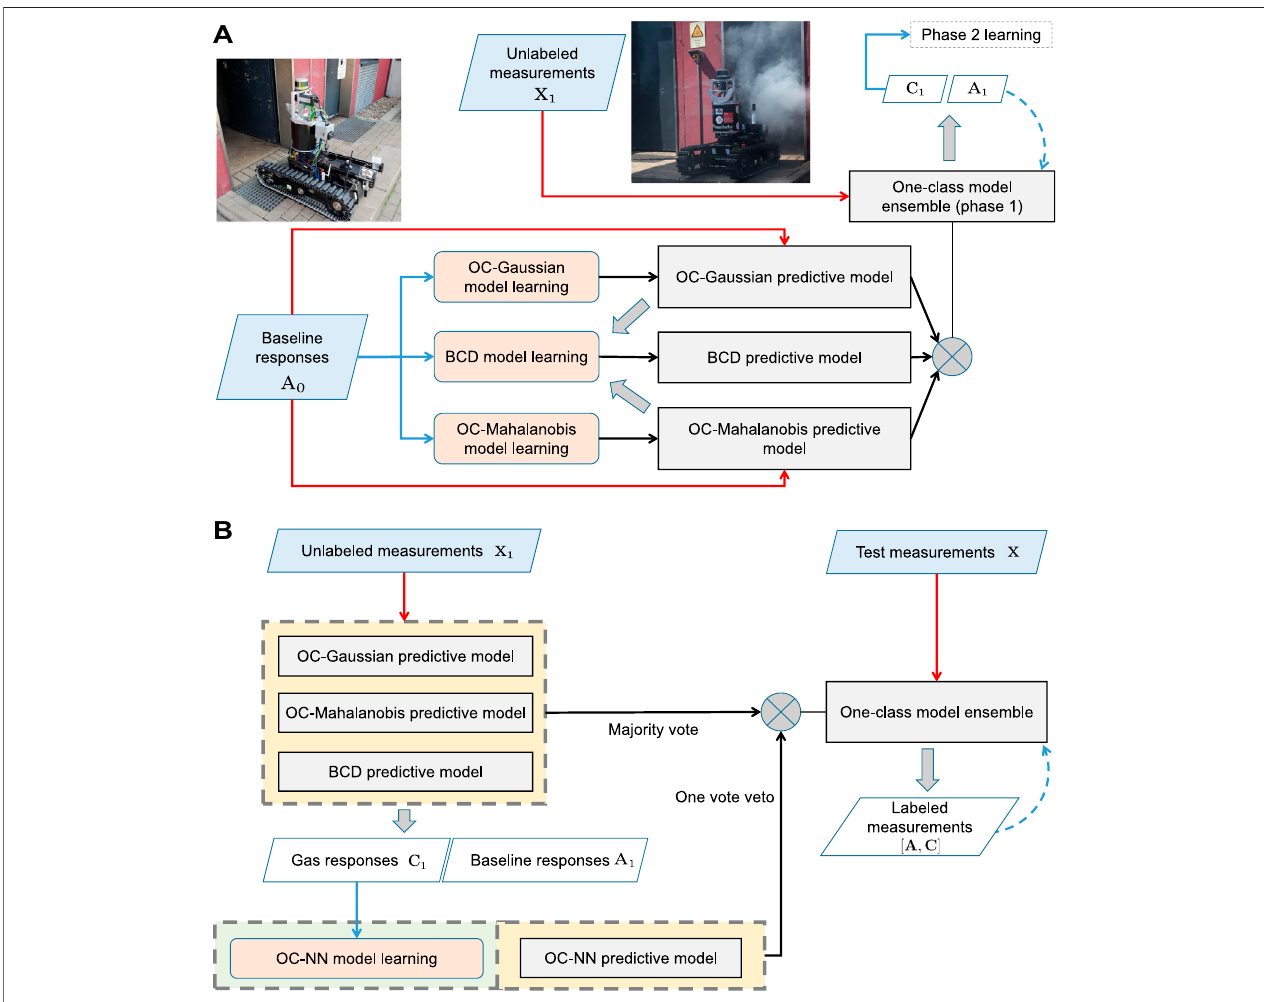
FIGURE4| Phase1andphase2modellearningoftheELBAalgorithm.Pleasereferto phase1learning , phase2learning and Ensemblecreation in Section2.1 for correspondingdetailsofthisdiagram. (A) Inthephase1modellearning,thee-noseisexposedtocleanairtotraintheOC-GaussianandtheOC-Mahalanobismodel,and theBCDmodel.Beforephase2learning,thesethreemodelsmakepredictionsonnewmeasurementswithlabelsindicatingthemasbaselineorgasresponses.Theself- labelledmeasurementsarealsousedtoupdatethemodels(whenbaselineresponsesareidenti fi ed)ortriggerphase2learning(whengasresponsesaredetected). (B) Inthephase2modellearning,aOne-ClassNearestNeighbour(OC-NN)modelistrained fromself-labeled non-airmeasurementswiththemodelspreviouslylearned in phase 1. The models learned in phase 1 and phase 2 are combined to form the one-class ensemble for gas detection. The models can be future updated online with new self-labelled